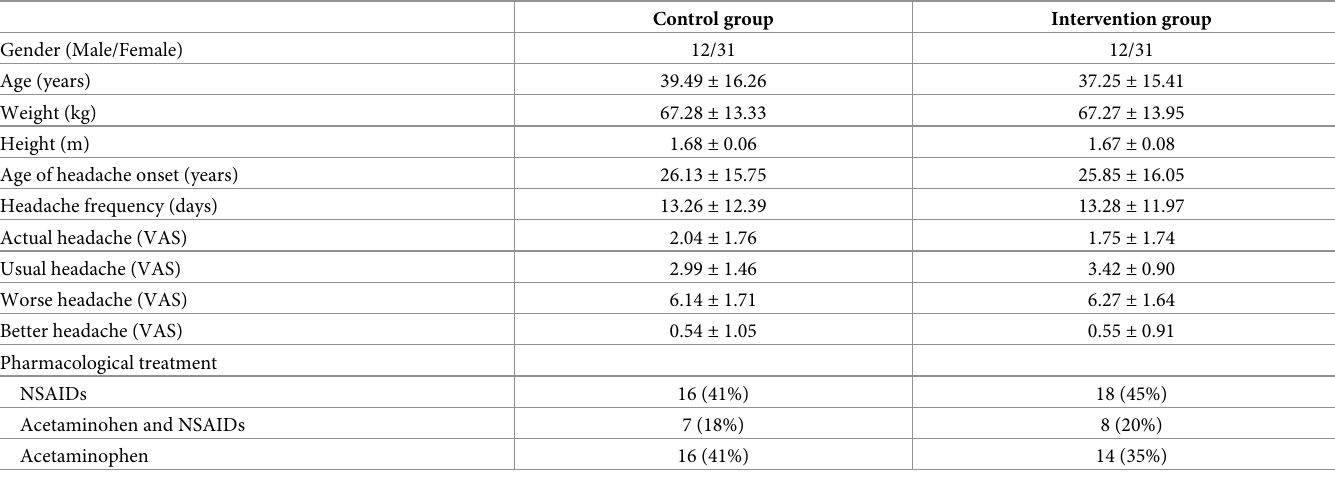
Table 1. Subject demographic characteristics at baseline.